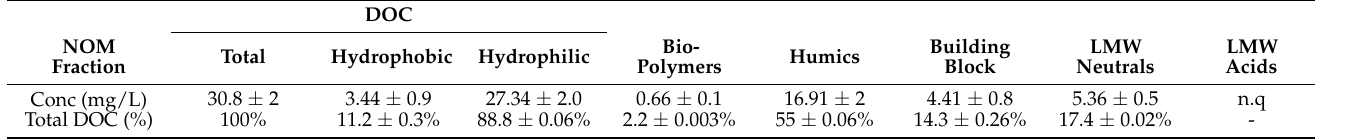
Table 3. Detailed fraction of organics in the